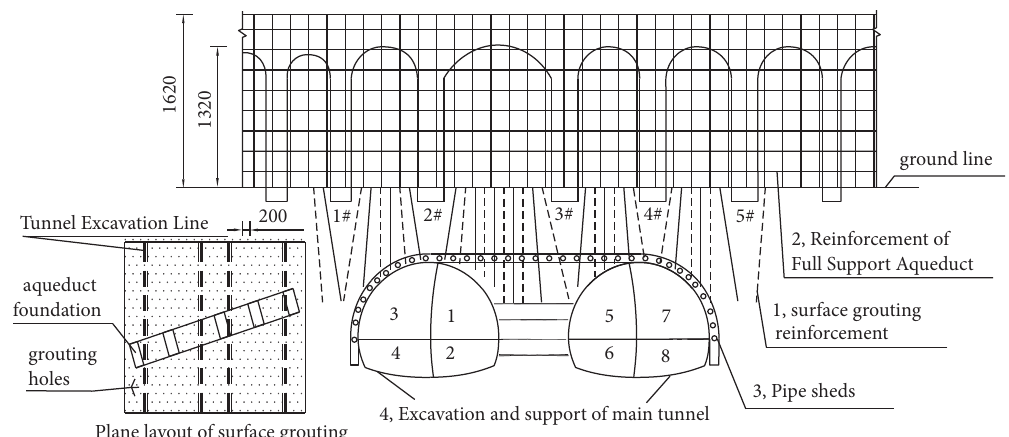
Figure 3: Excavation scheme of Dongfeng Aqueduct tunnel